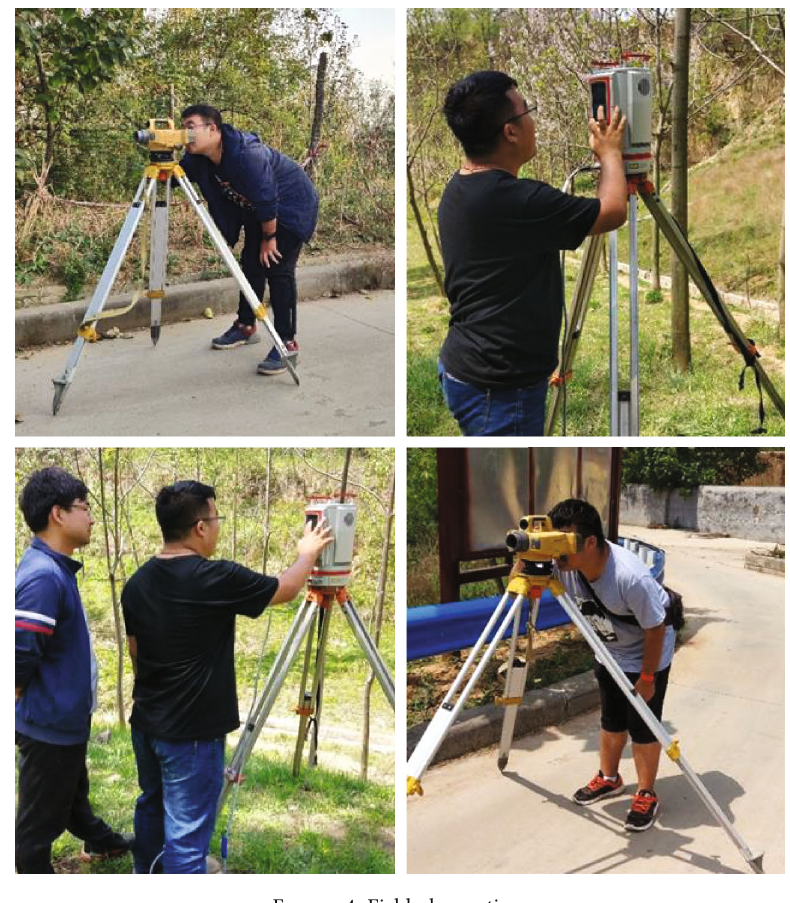
Figure 4: Field observation.